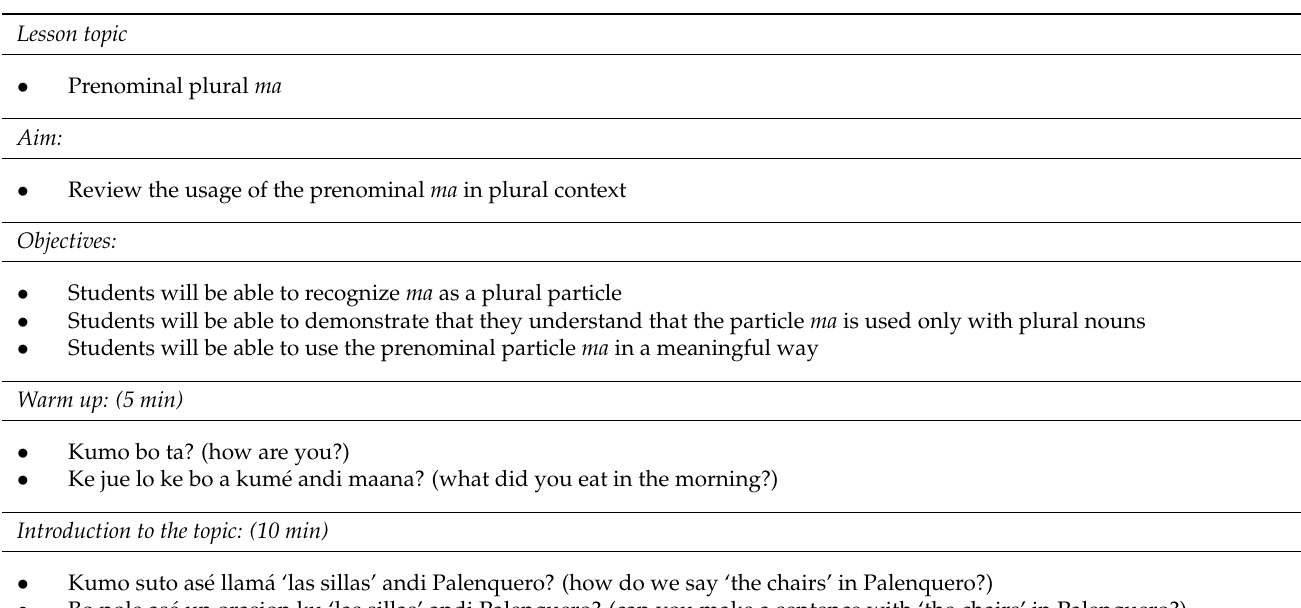
Table 2. Sample Lesson Plan for Pilot Study